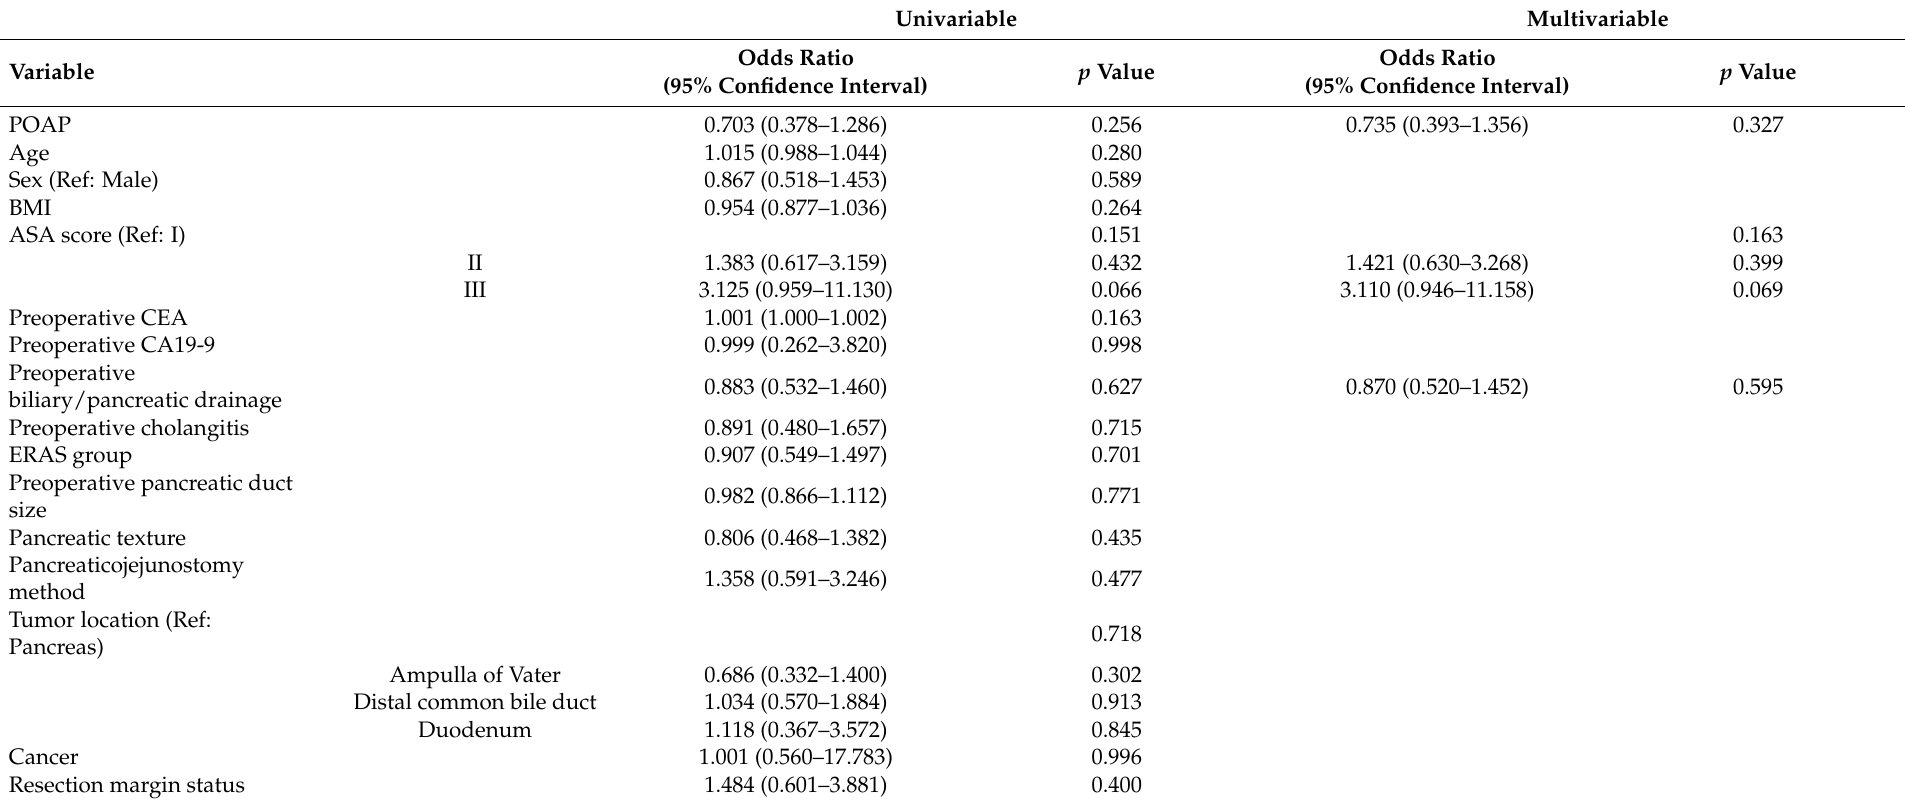
Table 3. Univariable and multivariable analyses of total postoperative complication rate after backward elimination by forcing the inclusion of postoperative acute pancreatitis (POAP). Univariable